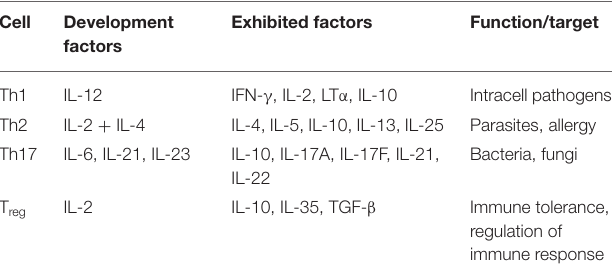
TABLE 2 | T cell subsets, differentiating factors and